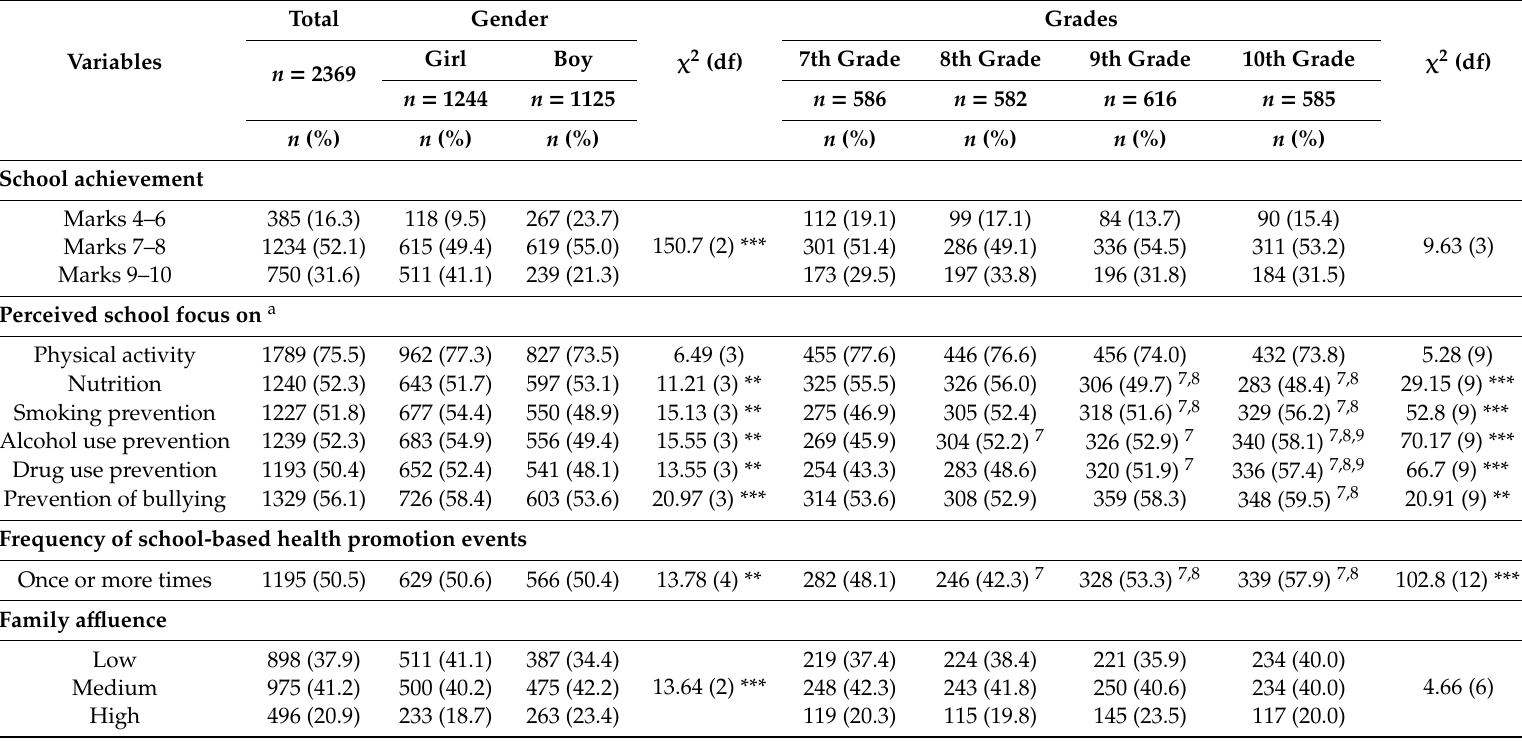
Table 2. Adolescents’ school achievement, perceived school focus on health and family a ffl